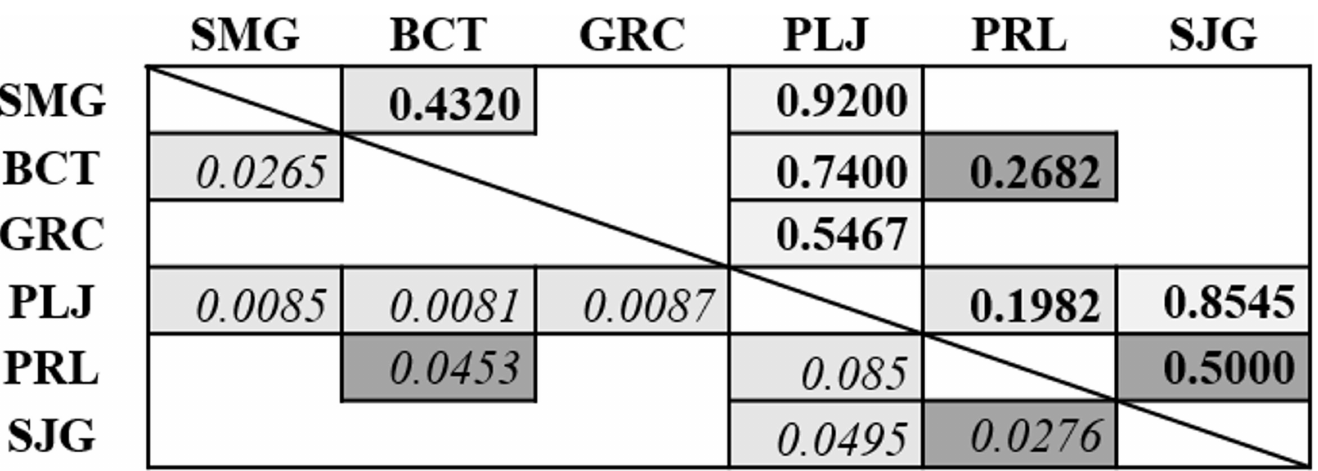
Fig 4. Analysis of similarity (ANOSIM) on square root transformed species incidences, using the software PAST [55]. Statistically significant differences in yeast community composition observed betweenislands/locations (SMG: S ã o Miguel,BCT: Biscoitos, GRC: Graciosa, PLJ: Lajidos, PRL: remaining locationsin Pico, SJG: S ã o Jorge). R -valuesare indicatedin bold, and P -valuesin italic. Light grey and dark grey boxes refer to comparisons made with yeast species obtainedin 2009 and 2010,